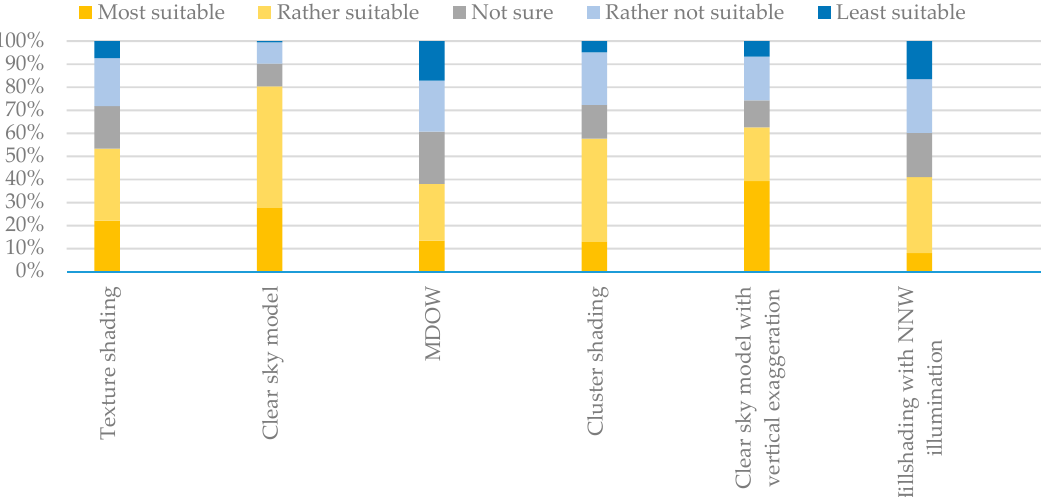
Figure 12. Survey results for V-shaped valleys.